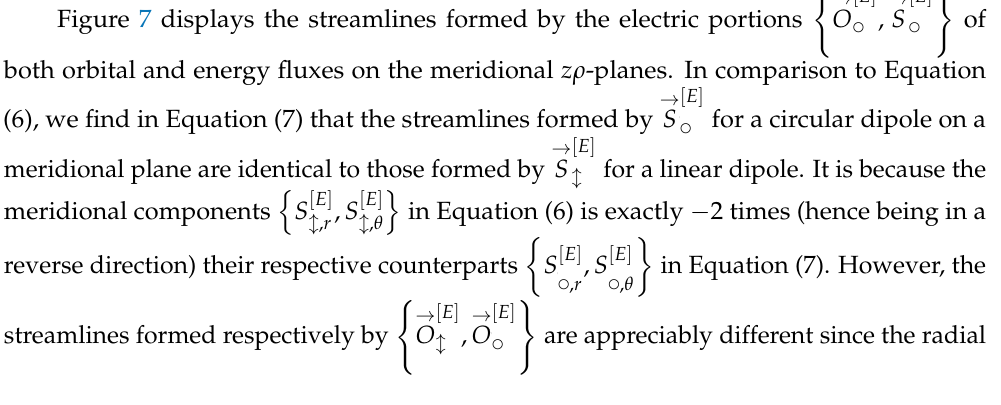
    Figure 1. ( a ) Decomposition of a Poynting vector P into an orbital energy flux O and a spin Figure 1. ( a ) Decomposition of a Poynting vector P into an orbital energy flux O and a spin     energy flux S energy flux S . Besides, M is a spin angular momentum (SAM) density. ( b ) The coordinate . Besides, M is a spin angular momentum (SAM) density. ( b ) The coordinate         systems. On the origin lies a primary electric point dipole represented by its unit vector ˆ p . ( c ) A systems. On the origin lies a primary electric point dipole represented by its unit vector ˆ p . ( c ) A Figure 1. ( a ) Decomposition of a Poynting vector P into an orbital energy flux O and a spin Figure 1. ( a ) Decomposition of a Poynting vector P into an orbital energy flux O and a spin Figure 1. ( a ) Decomposition of a Poynting vector P into an orbital energy flux O and a spin Figure 1. ( a ) Decomposition of a Poynting vector P into an orbital energy flux O and a spin         linear dipole ˆ p with its dipole axis lying parallel to the vertical axis leads to a pencil-hull-like linear dipole ˆ p with its dipole axis lying parallel to the vertical axis leads to a pencil-hull-like energy flux S energy flux S energy flux S . Besides, M is a spin angular momentum (SAM) density. ( b ) The coordinate . Besides, M is a spin angular momentum (SAM) density. ( b ) The coordinate . Besides, M is a spin angular momentum (SAM) density. ( b ) The coordinate energy flux S . Besides, M is a spin angular momentum (SAM) density. ( b ) The coordinate   systems. On the origin lies a primary electric point dipole represented by its unit vector ˆ p . ( c ) A systems. On the origin lies a primary electric point dipole represented by its unit vector ˆ p . ( c ) A systems. On the origin lies a primary electric point dipole represented by its unit vector ˆ p . ( c ) A tapered cylindrical surface designating higher values for the degree of circular polarization (DoCP). tapered cylindrical surface designating higher values for the degree of circular polarization (DoCP). systems. On the origin lies a primary electric point dipole represented by its unit vector ˆ p . ( c ) A with its dipole axis lying on the horizontal plane leads to a filled solid with its dipole axis lying on the horizontal plane leads to a filled solid ( d ) A circular dipole ˆ p ( d ) A circular dipole ˆ p linear dipole ˆ p with its dipole axis lying parallel to the vertical axis leads to a pencil-hull-like linear dipole ˆ p with its dipole axis lying parallel to the vertical axis leads to a pencil-hull-like linear dipole ˆ p with its dipole axis lying parallel to the vertical axis leads to a pencil-hull-like linear dipole ˆ p with its dipole axis lying parallel to the vertical axis leads to a pencil-hull-like           ○ ○ cone of higher values of DoCP. cone of higher values of DoCP. tapered cylindrical surface designating higher values for the degree of circular polarization (DoCP). tapered cylindrical surface designating higher values for the degree of circular polarization (DoCP). tapered cylindrical surface designating higher values for the degree of circular polarization (DoCP). Figure 1. ( a ) Decomposition of a Poynting vector P into an orbital energy flux O and a spin tapered cylindrical surface designating higher values for the degree of circular polarization (DoCP).     Figure 1. ( a ) Decomposition of a Poynting vector P into an orbital energy flux O and a spin  with its dipole axis lying on the horizontal plane leads to a filled solid with its dipole axis lying on the horizontal plane leads to a filled solid with its dipole axis lying on the horizontal plane leads to a filled solid ( d ) A circular dipole ˆ p ( d ) A circular dipole ˆ p ( d ) A circular dipole ˆ p  energy flux S . Besides, M is a spin angular momentum (SAM) density. ( b ) The coordinate with its dipole axis lying on the horizontal plane leads to a filled solid ( d ) A circular dipole ˆ p     energy flux S . Besides, M is a spin angular momentum (SAM) density. ( b ) The coordinate systems. On the origin lies a primary electric point dipole represented by its unit vector ˆ p . ( c ) A ○ ○ ○ cone of higher values of DoCP. cone of higher values of DoCP. cone of higher values of DoCP. ○ cone of higher values of DoCP.    systems. On the origin lies a primary electric point dipole represented by its unit vector ˆ p . ( c ) A  linear dipole ˆ p with its dipole axis lying parallel to the vertical axis leads to a pencil-hull-like  linear dipole ˆ p with its dipole axis lying parallel to the vertical axis leads to a pencil-hull-like    tapered cylindrical surface designating higher values for the degree of circular polarization (DoCP). Figure 1. ( a ) Decomposition of a Poynting vector P into an orbital energy flux O and a spin tapered cylindrical surface designating higher values for the degree of circular polarization (DoCP).   with its dipole axis lying on the horizontal plane leads to a filled solid ( d ) A circular dipole ˆ p  energy flux S . Besides, M is a spin angular momentum (SAM) density. ( b ) The coordinate with its dipole axis lying on the horizontal plane leads to a filled solid ( d ) A circular dipole ˆ p   ○  cone of higher values of DoCP. systems. On the origin lies a primary electric point dipole represented by its unit vector ˆ p . ( c ) A  ○ cone of higher values of DoCP. Figure 1. ( a ) Decomposition of a Poynting vector P into an orbital energy flux O and a spin    linear dipole ˆ p with its dipole axis lying parallel to the vertical axis leads to a pencil-hull-like energy flux S . Besides, M is a spin angular momentum (SAM) density. ( b ) The coordinate  tapered cylindrical surface designating higher values for the degree of circular polarization (DoCP). systems. On the origin lies a primary electric point dipole represented by its unit vector ˆ p . ( c ) A systems. On the origin lies a primary electric point dipole represented by its unit vector ˆ p . ( c ) A   with its dipole axis lying on the horizontal plane leads to a filled solid ( d ) A circular dipole ˆ p linear dipole ˆ p with its dipole axis lying parallel to the vertical axis leads to a pencil-hull-like linear dipole ˆ p with its dipole axis lying parallel to the vertical axis leads to a pencil-hull-like  Figure 1. ( a ) Decomposition of a Poynting vector P into an orbital energy flux O and a spin     ○ cone of higher values of DoCP. energy flux S . Besides, M is a spin angular momentum (SAM) density. ( b ) The coordinate tapered cylindrical surface designating higher values for the degree of circular polarization (DoCP). tapered cylindrical surface designating higher values for the degree of circular polarization (DoCP).  with its dipole axis lying on the horizontal plane leads to a filled solid ( d ) A circular dipole ˆ p systems. On the origin lies a primary electric point dipole represented by its unit vector ˆ p . ( c ) A    linear dipole ˆ p with its dipole axis lying parallel to the vertical axis leads to a pencil-hull-like ○ cone of higher values of DoCP. Figure 1. ( a ) Decomposition of a Poynting vector P into an orbital energy flux O and a spin     energy flux S . Besides, M is a spin angular momentum (SAM) density. ( b ) The coordinate tapered cylindrical surface designating higher values for the degree of circular polarization (DoCP). systems. On the origin lies a primary electric point dipole represented by its unit vector ˆ p . ( c ) A   Figure 1. ( a ) Decomposition of a Poynting vector P into an orbital energy flux O and a spin linear dipole ˆ p with its dipole axis lying parallel to the vertical axis leads to a pencil-hull-like    energy flux S . Besides, M is a spin angular momentum (SAM) density. ( b ) The coordinate tapered cylindrical surface designating higher values for the degree of circular polarization (DoCP).   systems. On the origin lies a primary electric point dipole represented by its unit vector ˆ p . ( c ) A Figure 1. ( a ) Decomposition of a Poynting vector P into an orbital energy flux O and a spin   linear dipole ˆ p with its dipole axis lying parallel to the vertical axis leads to a pencil-hull-like energy flux S . Besides, M is a spin angular momentum (SAM) density. ( b ) The coordinate  systems. On the origin lies a primary electric point dipole represented by its unit vector ˆ p . ( c ) A tapered cylindrical surface designating higher values for the degree of circular polarization (DoCP).         with its dipole axis lying on the horizontal plane leads to a filled solid ( d ) A circular dipole ˆ p linear dipole ˆ p with its dipole axis lying parallel to the vertical axis leads to a pencil-hull-like Figure 1. ( a ) Decomposition of a Poynting vector P into an orbital energy flux O and a spin Figure 1. ( a ) Decomposition of a Poynting vector P into an orbital energy flux O and a spin Figure 1. ( a ) Decomposition of a Poynting vector P into an orbital energy flux O and a spin Figure 1. ( a ) Decomposition of a Poynting vector P into an orbital energy flux O and a spin           ○ cone of higher values of DoCP. tapered cylindrical surface designating higher values for the degree of circular polarization (DoCP). energy flux S energy flux S energy flux S energy flux S . Besides, M is a spin angular momentum (SAM) density. ( b ) The coordinate . Besides, M is a spin angular momentum (SAM) density. ( b ) The coordinate . Besides, M is a spin angular momentum (SAM) density. ( b ) The coordinate . Besides, M is a spin angular momentum (SAM) density. ( b ) The coordinate    with its dipole axis lying on the horizontal plane leads to a filled solid ( d ) A circular dipole ˆ p systems. On the origin lies a primary electric point dipole represented by its unit vector ˆ p . ( c ) A systems. On the origin lies a primary electric point dipole represented by its unit vector ˆ p . ( c ) A systems. On the origin lies a primary electric point dipole represented by its unit vector ˆ p . ( c ) A systems. On the origin lies a primary electric point dipole represented by its unit vector ˆ p . ( c ) A  Figure 1. ( a ) Decomposition of a Poynting vector P into an orbital energy flux O and a spin   ○ cone of higher values of DoCP. linear dipole ˆ p with its dipole axis lying parallel to the vertical axis leads to a pencil-hull-like linear dipole ˆ p with its dipole axis lying parallel to the vertical axis leads to a pencil-hull-like linear dipole ˆ p with its dipole axis lying parallel to the vertical axis leads to a pencil-hull-like linear dipole ˆ p with its dipole axis lying parallel to the vertical axis leads to a pencil-hull-like      energy flux S . Besides, M is a spin angular momentum (SAM) density. ( b ) The coordinate tapered cylindrical surface designating higher values for the degree of circular polarization (DoCP). tapered cylindrical surface designating higher values for the degree of circular polarization (DoCP). tapered cylindrical surface designating higher values for the degree of circular polarization (DoCP). tapered cylindrical surface designating higher values for the degree of circular polarization (DoCP). systems. On the origin lies a primary electric point dipole represented by its unit vector ˆ p . ( c ) A       with its dipole axis lying on the horizontal plane leads to a filled solid with its dipole axis lying on the horizontal plane leads to a filled solid with its dipole axis lying on the horizontal plane leads to a filled solid with its dipole axis lying on the horizontal plane leads to a filled solid ( d ) A circular dipole ˆ p ( d ) A circular dipole ˆ p ( d ) A circular dipole ˆ p ( d ) A circular dipole ˆ p Figure 1. ( a ) Decomposition of a Poynting vector P into an orbital energy flux O and a spin Figure 1. ( a ) Decomposition of a Poynting vector P into an orbital energy flux O and a spin     Figure 1. ( a ) Decomposition of a Poynting vector P into an orbital energy flux O and a spin linear dipole ˆ p with its dipole axis lying parallel to the vertical axis leads to a pencil-hull-like        ○ ○ ○ ○ cone of higher values of DoCP. cone of higher values of DoCP. cone of higher values of DoCP. cone of higher values of DoCP. energy flux S energy flux S . Besides, M is a spin angular momentum (SAM) density. ( b ) The coordinate . Besides, M is a spin angular momentum (SAM) density. ( b ) The coordinate energy flux S . Besides, M is a spin angular momentum (SAM) density. ( b ) The coordinate      tapered cylindrical surface designating higher values for the degree of circular polarization (DoCP).  Figure 1. ( a ) Decomposition of a Poynting vector P into an orbital energy flux O and a spin systems. On the origin lies a primary electric point dipole represented by its unit vector ˆ p . ( c ) A systems. On the origin lies a primary electric point dipole represented by its unit vector ˆ p . ( c ) A systems. On the origin lies a primary electric point dipole represented by its unit vector ˆ p . ( c ) A with its dipole axis lying on the horizontal plane leads to a filled solid ( d ) A circular dipole ˆ p     energy flux S . Besides, M is a spin angular momentum (SAM) density. ( b ) The coordinate  linear dipole ˆ p with its dipole axis lying parallel to the vertical axis leads to a pencil-hull-like linear dipole ˆ p with its dipole axis lying parallel to the vertical axis leads to a pencil-hull-like linear dipole ˆ p with its dipole axis lying parallel to the vertical axis leads to a pencil-hull-like ○ cone of higher values of DoCP.    Figure 1. ( a ) Decomposition of a Poynting vector P into an orbital energy flux O and a spin   systems. On the origin lies a primary electric point dipole represented by its unit vector ˆ p . ( c ) A  tapered cylindrical surface designating higher values for the degree of circular polarization (DoCP). tapered cylindrical surface designating higher values for the degree of circular polarization (DoCP). tapered cylindrical surface designating higher values for the degree of circular polarization (DoCP). energy flux S . Besides, M is a spin angular momentum (SAM) density. ( b ) The coordinate linear dipole ˆ p with its dipole axis lying parallel to the vertical axis leads to a pencil-hull-like with its dipole axis lying on the horizontal plane leads to a filled solid ( d ) A circular dipole ˆ p with its dipole axis lying on the horizontal plane leads to a filled solid ( d ) A circular dipole ˆ p        systems. On the origin lies a primary electric point dipole represented by its unit vector ˆ p . ( c ) A Figure 1. ( a ) Decomposition of a Poynting vector P into an orbital energy flux O and a spin Figure 1. ( a ) Decomposition of a Poynting vector P into an orbital energy flux O and a spin tapered cylindrical surface designating higher values for the degree of circular polarization (DoCP). ○ cone of higher values of DoCP.      linear dipole ˆ p with its dipole axis lying parallel to the vertical axis leads to a pencil-hull-like energy flux S energy flux S . Besides, M is a spin angular momentum (SAM) density. ( b ) The coordinate . Besides, M is a spin angular momentum (SAM) density. ( b ) The coordinate  with its dipole axis lying on the horizontal plane leads to a filled solid ( d ) A circular dipole ˆ p  tapered cylindrical surface designating higher values for the degree of circular polarization (DoCP). systems. On the origin lies a primary electric point dipole represented by its unit vector ˆ p . ( c ) A systems. On the origin lies a primary electric point dipole represented by its unit vector ˆ p . ( c ) A ○ cone of higher values of DoCP.    with its dipole axis lying on the horizontal plane leads to a filled solid ( d ) A circular dipole ˆ p Figure 1. ( a ) Decomposition of a Poynting vector P into an orbital energy flux O and a spin  linear dipole ˆ p with its dipole axis lying parallel to the vertical axis leads to a pencil-hull-like linear dipole ˆ p with its dipole axis lying parallel to the vertical axis leads to a pencil-hull-like     ○ cone of higher values of DoCP. energy flux S . Besides, M is a spin angular momentum (SAM) density. ( b ) The coordinate tapered cylindrical surface designating higher values for the degree of circular polarization (DoCP). tapered cylindrical surface designating higher values for the degree of circular polarization (DoCP).  systems. On the origin lies a primary electric point dipole represented by its unit vector ˆ p . ( c ) A with its dipole axis lying on the horizontal plane leads to a filled solid with its dipole axis lying on the horizontal plane leads to a filled solid ( d ) A circular dipole ˆ p ( d ) A circular dipole ˆ p   linear dipole ˆ p with its dipole axis lying parallel to the vertical axis leads to a pencil-hull-like ○ ○ cone of higher values of DoCP. cone of higher values of DoCP.        tapered cylindrical surface designating higher values for the degree of circular polarization (DoCP). Figure 1. ( a ) Decomposition of a Poynting vector P into an orbital energy flux O and a spin Figure 1. ( a ) Decomposition of a Poynting vector P into an orbital energy flux O and a spin     with its dipole axis lying on the horizontal plane leads to a filled solid ( d ) A circular dipole ˆ p  energy flux S energy flux S . Besides, M is a spin angular momentum (SAM) density. ( b ) The coordinate . Besides, M is a spin angular momentum (SAM) density. ( b ) The coordinate   ○ cone of higher values of DoCP. Figure 1. ( a ) Decomposition of a Poynting vector P into an orbital energy flux O and a spin  systems. On the origin lies a primary electric point dipole represented by its unit vector ˆ p . ( c ) A systems. On the origin lies a primary electric point dipole represented by its unit vector ˆ p . ( c ) A   energy flux S . Besides, M is a spin angular momentum (SAM) density. ( b ) The coordinate linear dipole ˆ p with its dipole axis lying parallel to the vertical axis leads to a pencil-hull-like linear dipole ˆ p with its dipole axis lying parallel to the vertical axis leads to a pencil-hull-like   systems. On the origin lies a primary electric point dipole represented by its unit vector ˆ p . ( c ) A tapered cylindrical surface designating higher values for the degree of circular polarization (DoCP). tapered cylindrical surface designating higher values for the degree of circular polarization (DoCP). linear dipole ˆ p with its dipole axis lying parallel to the vertical axis leads to a pencil-hull-like  tapered cylindrical surface designating higher values for the degree of circular polarization (DoCP). with its dipole axis lying on the horizontal plane leads to a filled solid ( d ) A circular dipole ˆ p  cone of higher values of DoCP. 